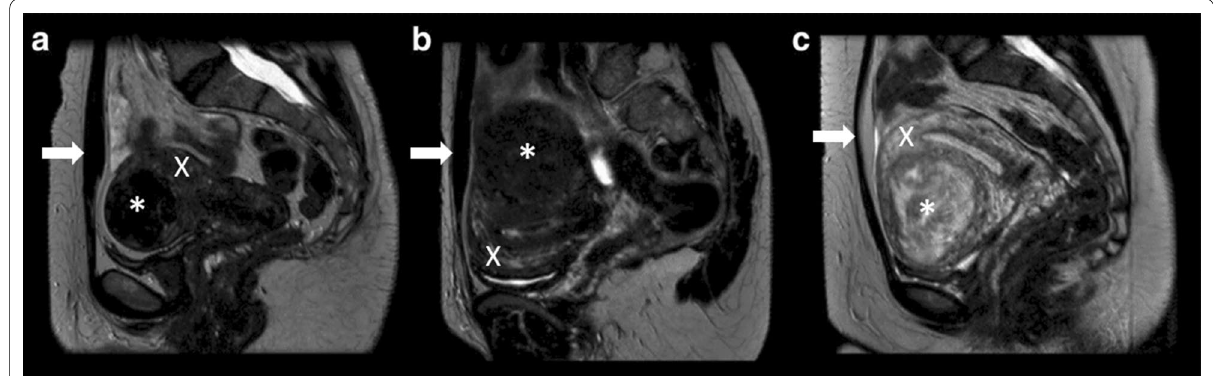
Fig. 1 Funaki classification. a Funaki I fibroid (signal intensity lower than myometrium and muscle); b Funaki II fibroid (signal intensity lower than myometrium, but higher than muscle); c Funaki III fibroid (signal intensity higher than muscle and myometrium). Asterisks (*) are located in the uterine fibroid. Arrows point at abdominal muscle. Cross (X) is located in myometrium